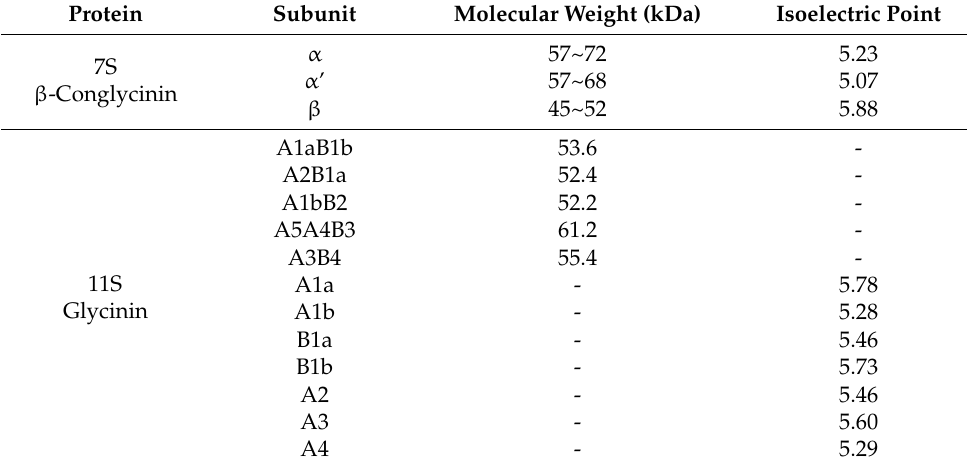
Table 2. The composition and functions of 7S and 11S